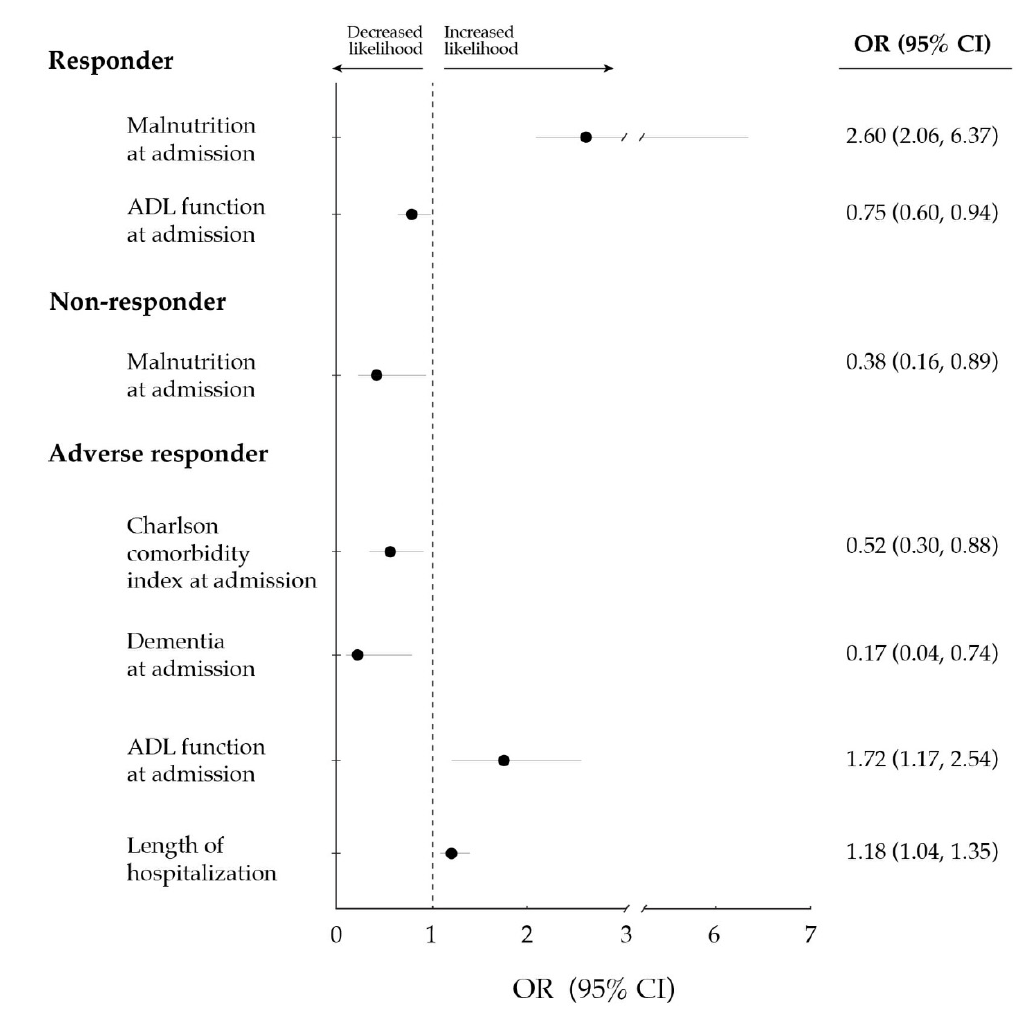
Figure 1. Significant ( p < 0.05) associations between: (i) demographic and clinical variables at baseline (i.e., two weeks before hospitalization) or upon hospital admission; and (ii) the response of functional ability (i.e., ability to perform activities of daily living [ADLs] independently) to the exercise intervention (i.e., responder [improvement], non-responder [no change] or adverse responder [decrease]). Data are shown as odds ratio (OR) along with 95% confidence interval (CI), and were computed through multivariate logistic regression analyses (fitted for those variables showing a p -value ≤ 0.157 in univariate analyses).